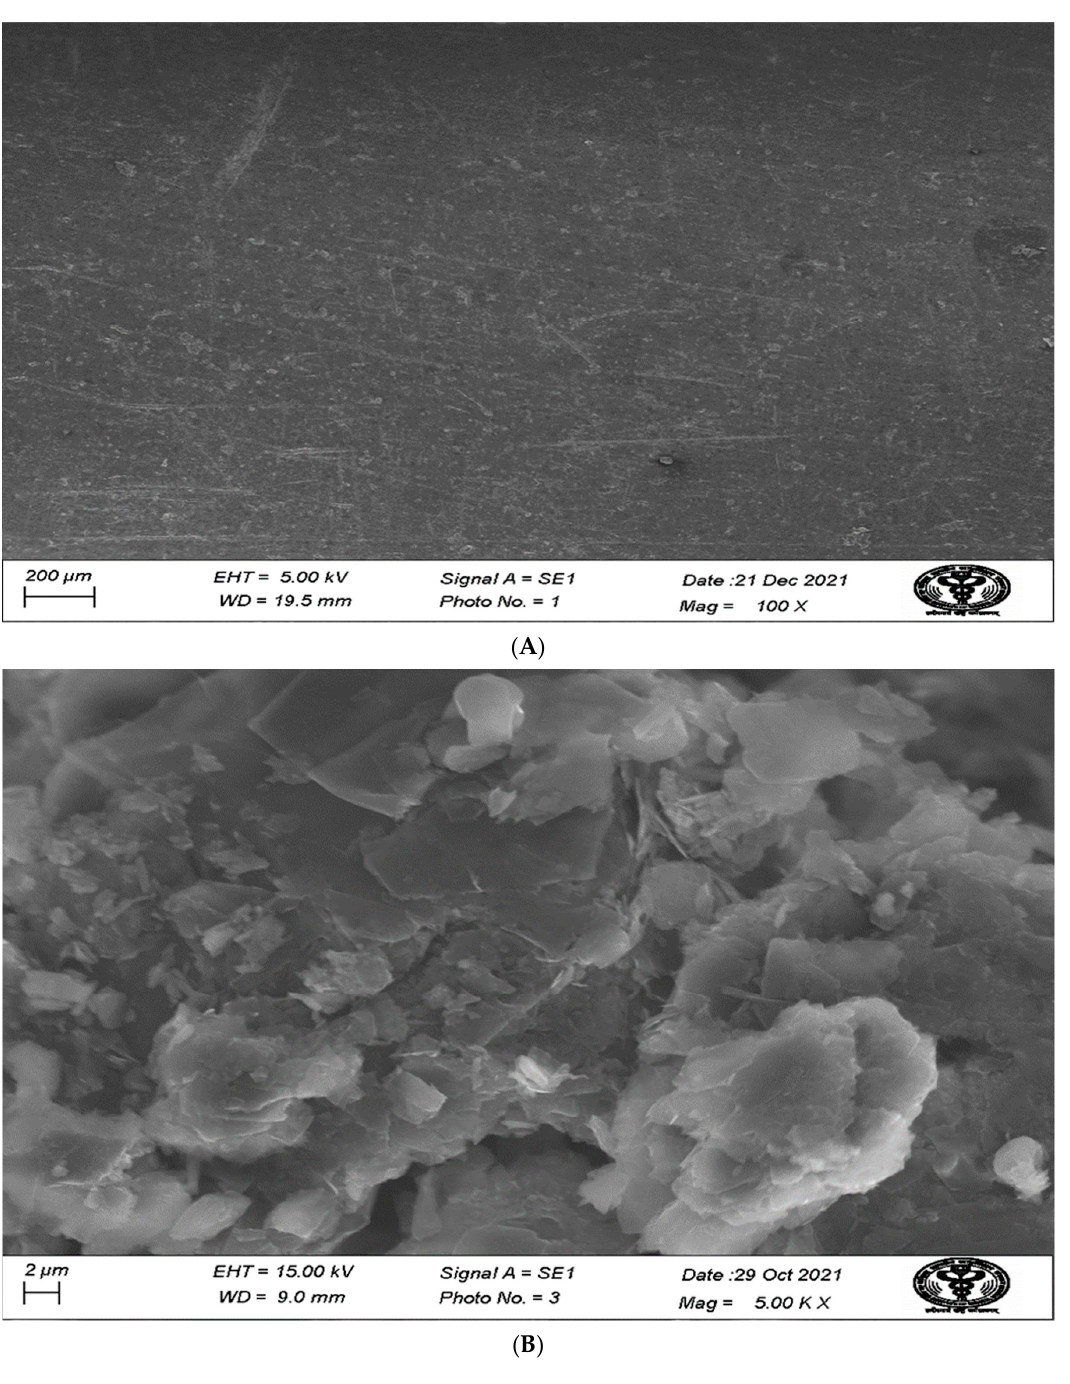
Figure 6. Scanning electron microscopy (SEM) image of bare PG electrode ( A ) and AChENPs/ChONPs/GONS/PtNPs nanocomposite onto PG electrode ( B ). (AChENPs = Acetylcho- line esterase nanoparticles; ChONPs = Choline oxide nanoparticles; GONS = Graphene nanosheets; PtNPs = Platinum nanoparticles; PGE= Pencil graphite